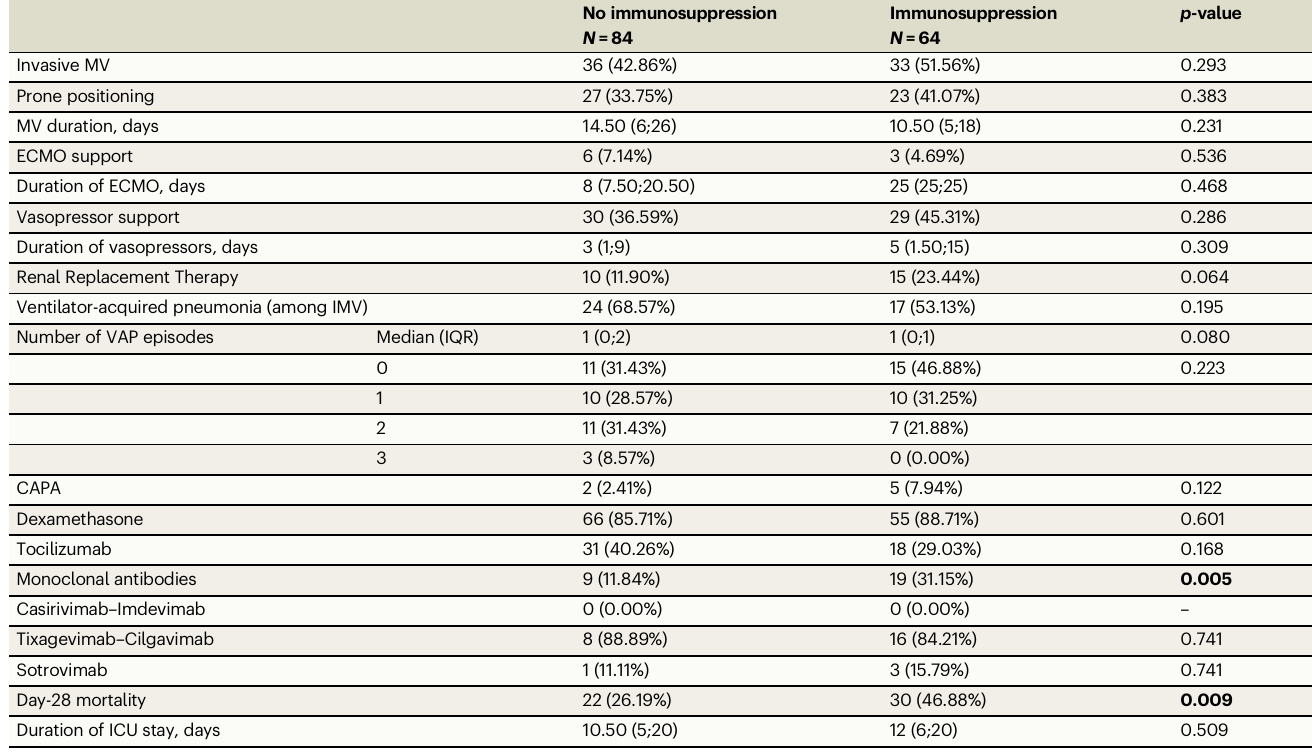
Table 5 | Intensive care management and outcomes of the 148 patients with severe variant Omicron infection during their ICU stay according to the existence of underlying